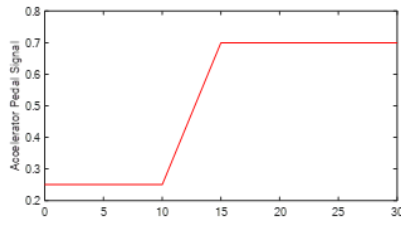
Figure 13. Acceleration pedal.